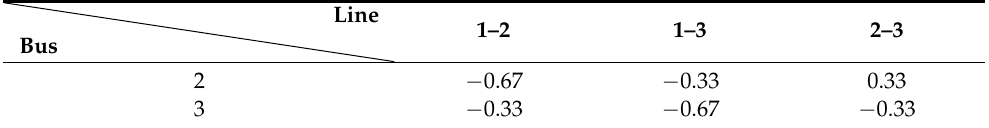
Table 3. Calculating example of BTF .